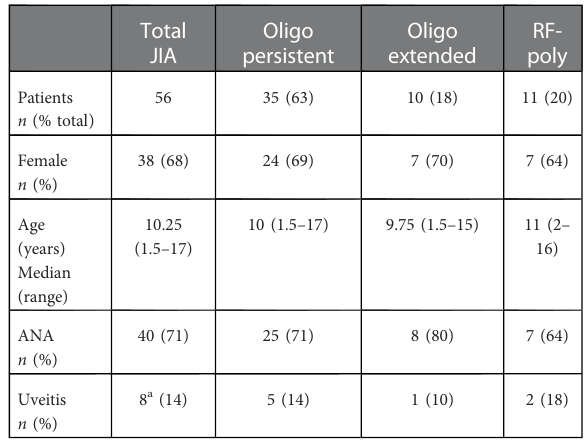
TABLE 2 Description of patient cohort included in bead array, grouped by